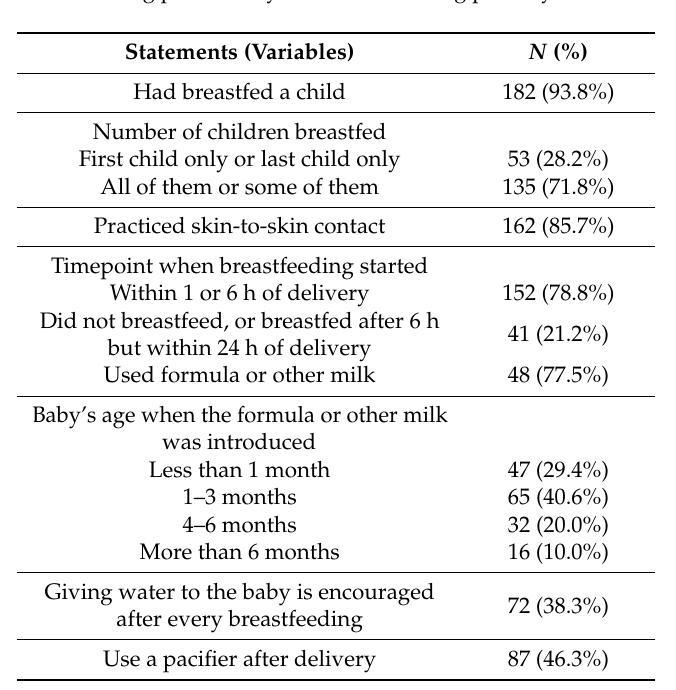
Table 2. Breastfeeding practices by mothers attending primary healthcare centers